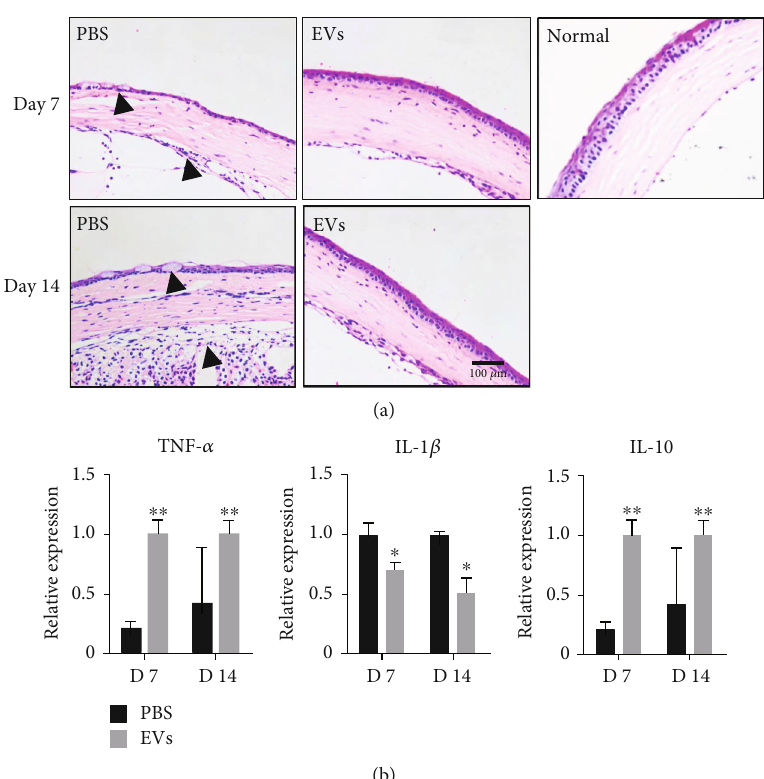
Figure 6: Enhanced therapeutic e ff ect of EVs in the alkali burn model. (a) H&E staining of the cornea demonstrated stromal edema and in fl ammatory cell in fi ltration on days 7 and 14 after injury in EV-treated mice, compared with the cornea without injury. The arrowheads pointed to the disorganized fi bers and phlyctenule in the epithelium layer. The degree of repair of the epithelial layer in the control group was signi fi cantly lower than that in the treatment group. (b) qRT-PCR revealed that mRNA levels of TNF- α and IL-1 β were highly decreased after treatment, while anti-in fl ammatory factor and IL-10 were increased in vivo . All data were shown as means ± SEM in triplicate assays. ∗ P < 0 : 05 , ∗∗ P < 0 : 01 versus